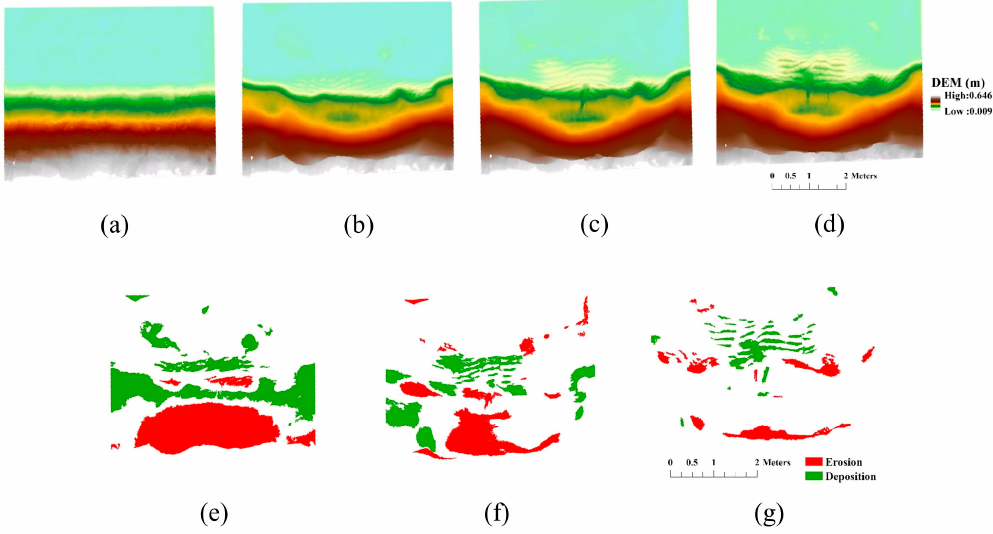
Figure 11. Beach evolution based on CMA analysis and beach models with 1 cm resolution. The upper figures are beach models showing the initial model ( a ) and models after one ( b ), two ( c ), and three ( d ) periods of wave application. ( e , f ) show the changing areas of sediment erosion and deposition between consecutive beach models that occurred after one ( e ), two ( f ), and three ( g ) periods of wave application. Each period of wave application lasted 10 min.